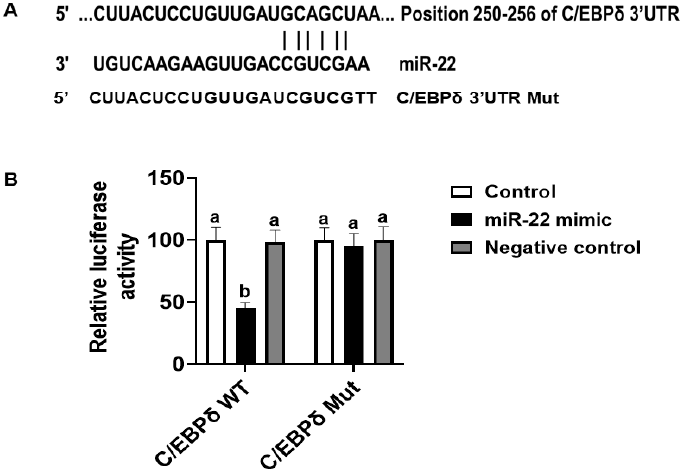
Figure 4. Luciferase assay. ( A ) There is a putative miR ‐ 22 binding site at the 3 ′‐ UTR of the C/EBP δ gene (TargetScan, accessed on 1 September, 2021). ( B ) Constructed luciferase vectors and miR ‐ 22